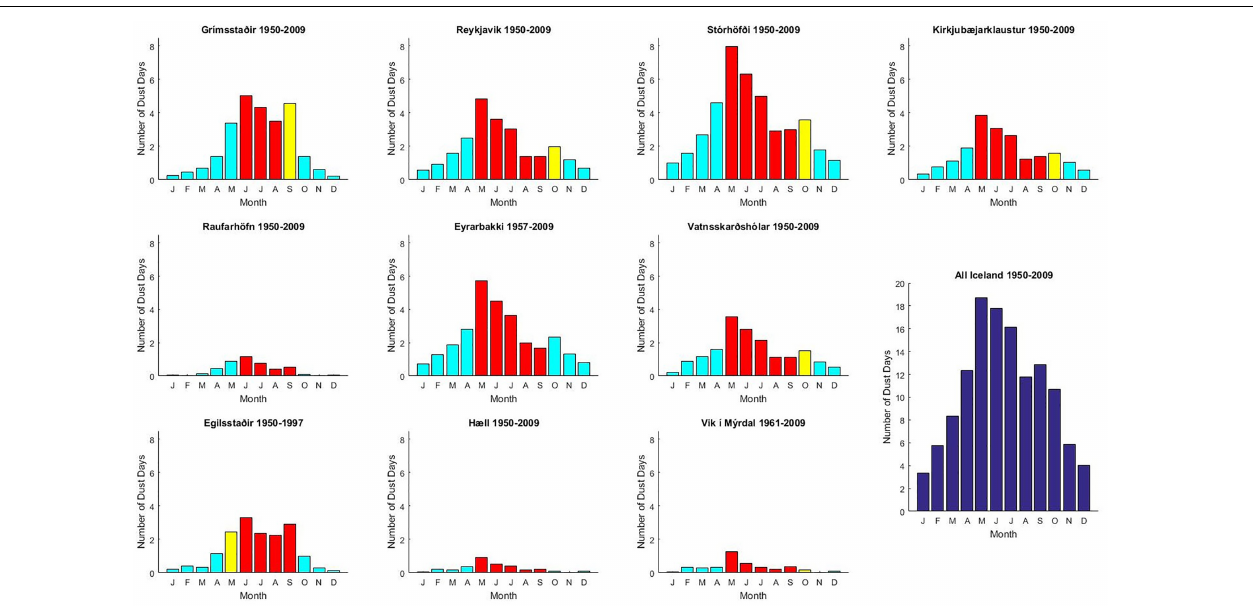
FIGURE 4 | Average number of dust days per year, with cold season (cyan), warm season (red), and transitional (yellow). NE stations in the first column, SW stations in the second column, and South stations in the third and fourth column. The bottom-right graph depicts the average number of dust days per year for all of Iceland.